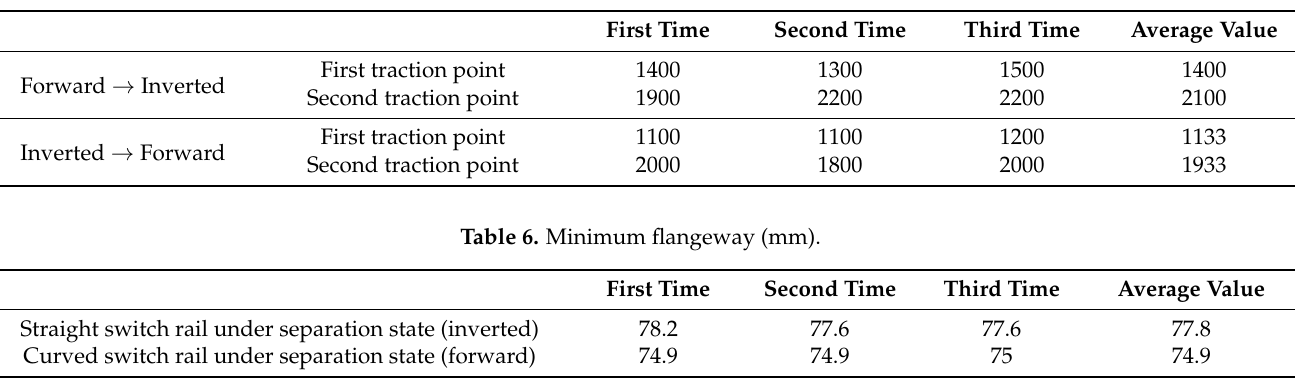
Table 6. Minimum flangeway (mm).